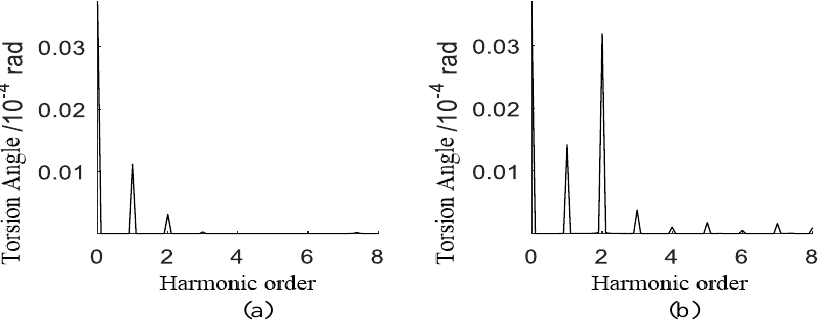
Figure 11. Torsional vibration spectrum of generator rotor: ( a ) misalignment 3 mm, short-circuit 1%; ( b ) misalignment 3 mm, short-circuit 10%.